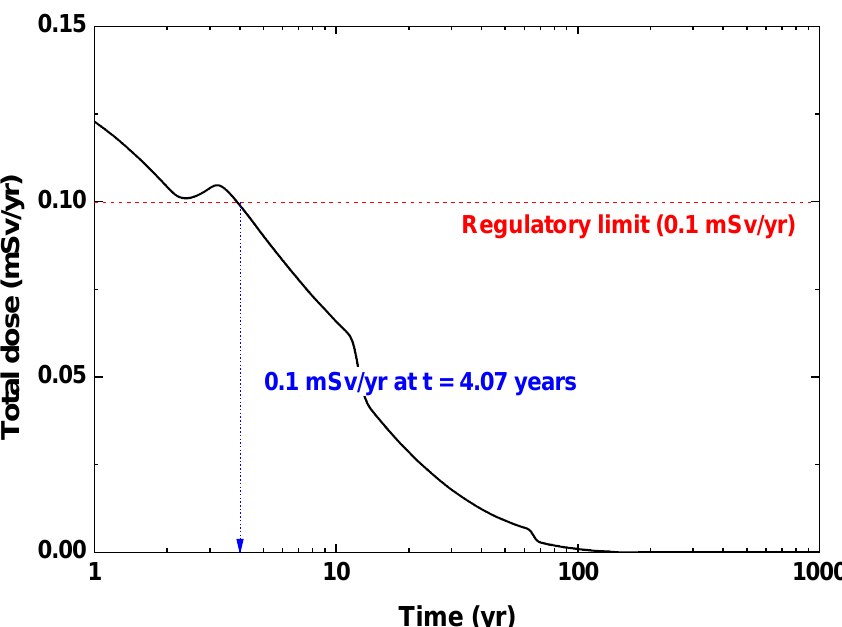
Figure 2. Total exposure dose as a function of time after the NPP decommissioning calculated with RESRAD-ONSITE code for Wolsong NPP site.